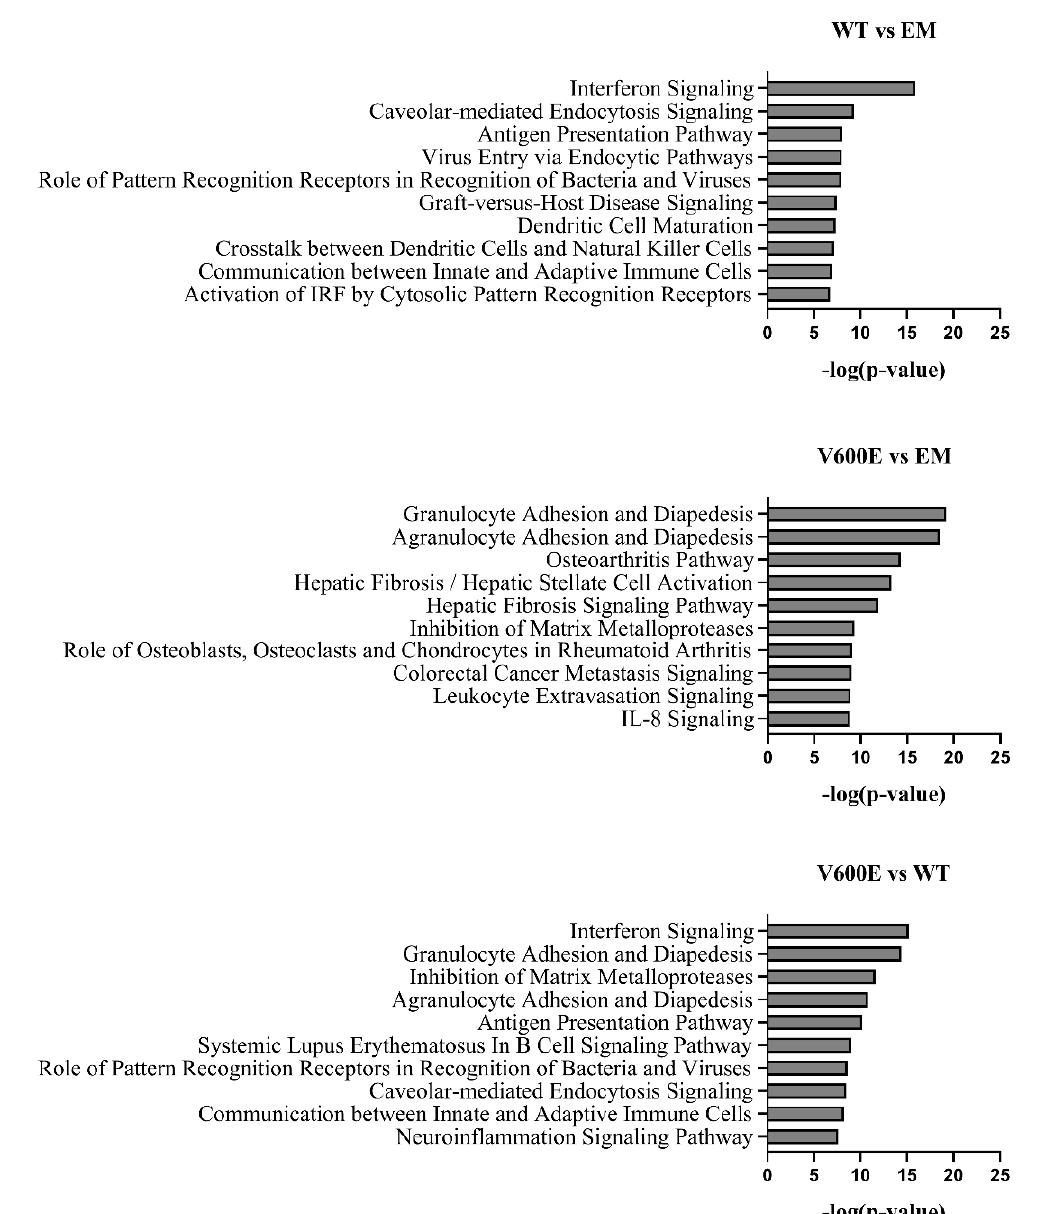
Figure 9. Top 10 significantly dysregulated canonical pathways. The bars present the various pathways in comparisons (WT vs. EM, V600E vs. EM, V600E vs. WT) based on a significant enrichment score (–log( p -value)).